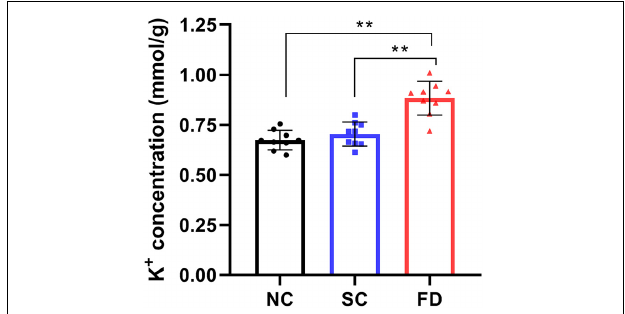
FIGURE 5 | Measurement of K + concentration in retinas after 4 weeks of treatment. The result indicated that the K + concentration in FD guinea pigs were higher than those in NC and SC guinea pigs (** P <